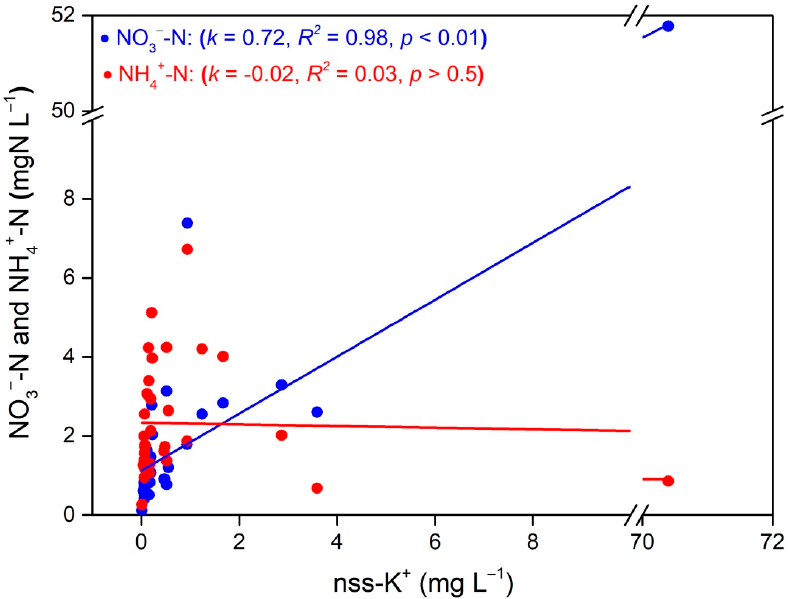
+ –N, and nss-K + in wet − –N, NH 4